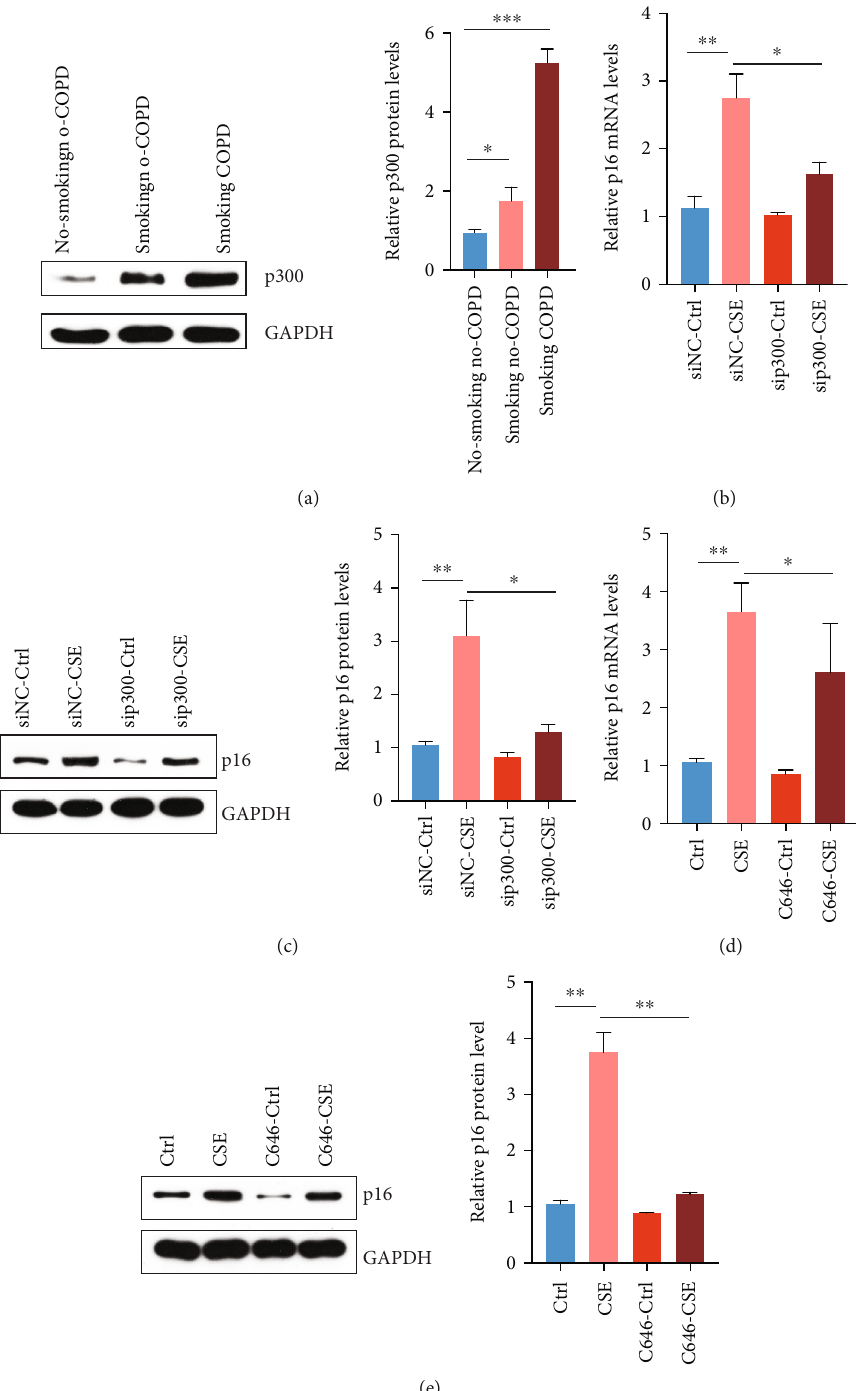
Figure 4: Increased p300 mediated the high expression of p16. (a) Western Blot was used to detect the expression of p300 in peripheral blood EPCs of nonsmoking non-COPD, smoking non-COPD, and smoking COPD patients setting each group with 20 samples. (b) Peripheral blood EPCs from nonsmoking non-COPD patients were treated with 5% CSE, p300 was knocked down by siRNA, and the expression of p16 was detected by RT-PCR. (c) Peripheral blood EPCs from nonsmoking non-COPD patients were treated with 5% CSE, p300 was knocked down by siRNA, and the expression of p16 was tested by Western Blot. (d) Peripheral blood EPCs from nonsmoking non-COPD patients were treated with 5% CSE and p300 small molecule inhibitor C646, and the expression of p16 was detected by RT-PCR. (e) Peripheral blood EPCs from nonsmoking non-COPD patients were treated with 5% CSE and p300 small molecule inhibitor C646, and the expression of p16 was tested by Western Blot. ∗ p < 0 : 05 , ∗∗ p < 0 : 01 , and ∗∗∗ p < 0 : 001